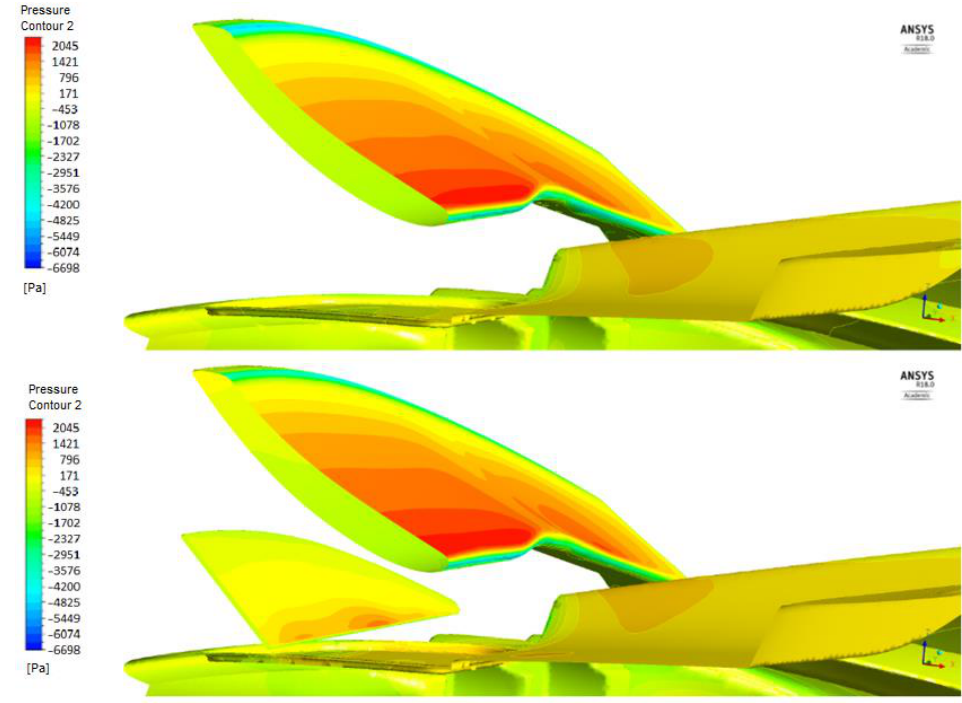
Figure 13. Spoiler and booster flap surface pressure distributions for a spoiler angle of 30 degrees.